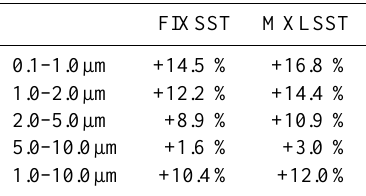
Table 4. Simulated percentage changes in annual and global mean dust burden in each size bin with FIXSST ((FIXSST